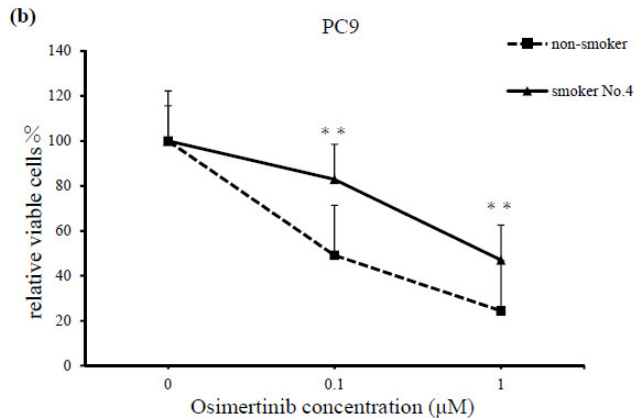
Figure 4. Comparisons of PC9 cell lines cultured for 72 h with various concentrations of ( a ) afatinib and ( b ) osimertinib (0, 0.1, and 1 µ M) and serum from the non-smoker and smoker No. 4. Serum from the smoker demonstrated significant resistance to afatinib and osimertinib treatment, compared with serum from non-smoker ( p < 0.001). Cell survival was assessed using a cell counting kit (CCK)-F. Results are means ± SEM of five independent experiments.